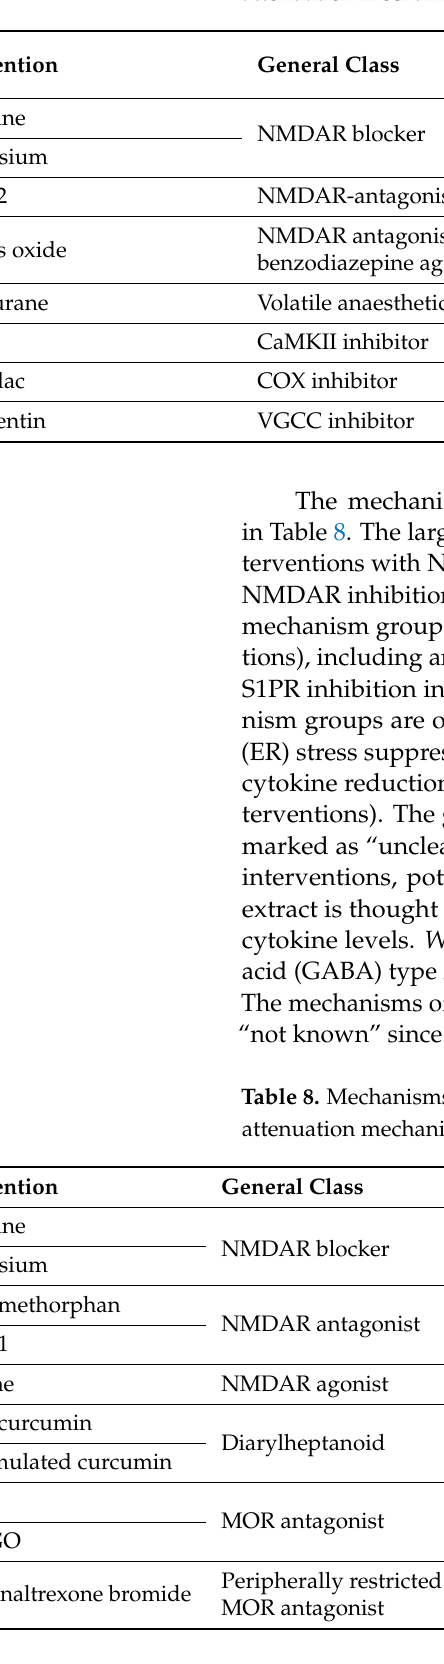
Table 7. Mechanisms of the interventions in fentanyl trials. Eight interventions’ general class, OIH attenuation mechanism, and mechanism group based on the shared pathway for OIH attenuation.